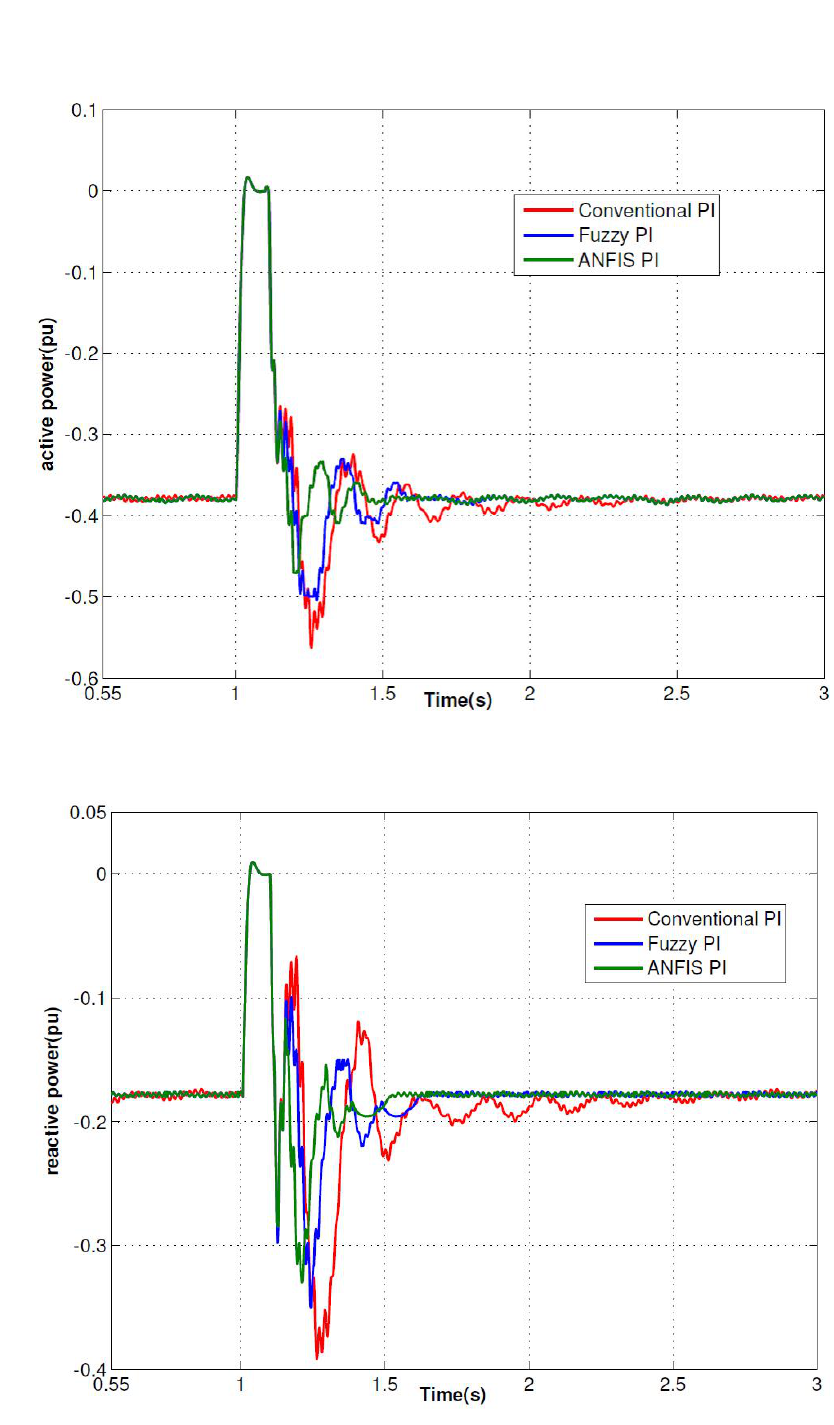
Figure 9. (a) Active power (b) reactive power at inverter AC bus for a 5 cycle three phase fault on inverter side AC